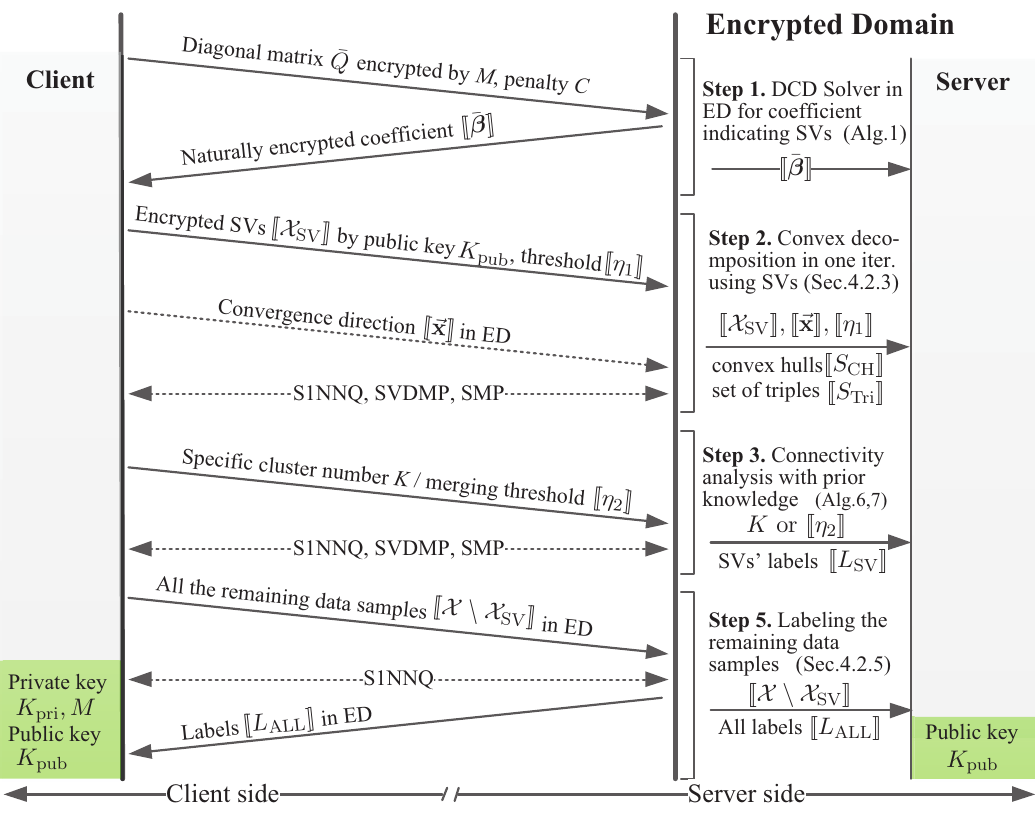
Figure 3. The flow diagram for approaches of MPPSVC. To keep consistent with Table 1, we use Steps 1, 2, 3, and 5 to denote the four steps of